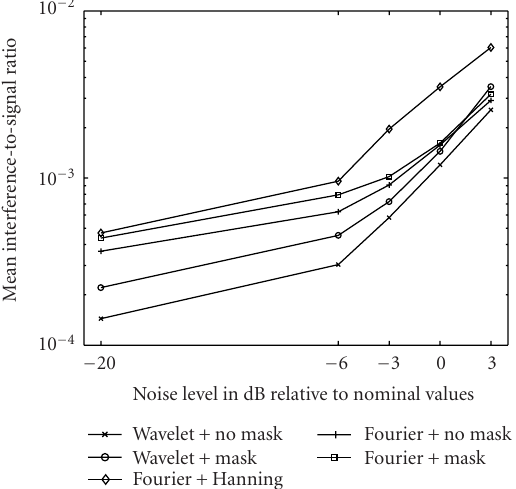
Figure 11: Comparison of the mean ISR for dust as a function of noise in five di ff erent configurations, namely, wSMICA without mask, wSMICA with mask, fSMICA without mask, fSMICA with mask, and fSMICA with Hanning apodizing window.